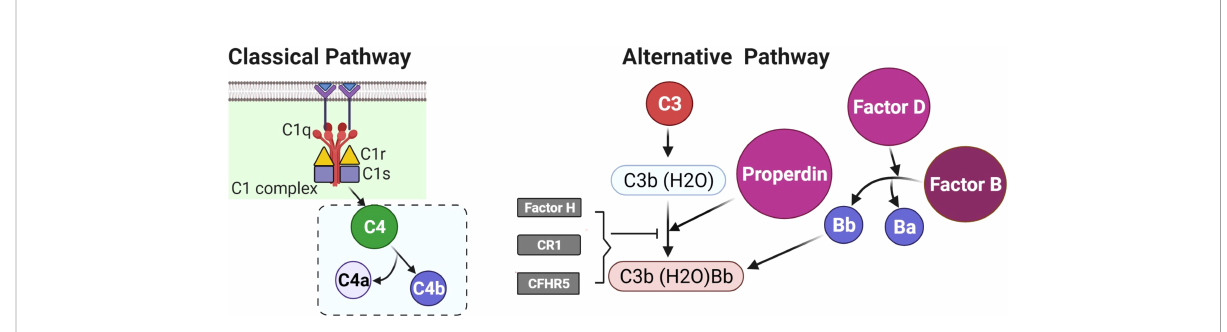
FIGURE 1 A schematic to illustrate the initiating proteins of the classical and alternate complement